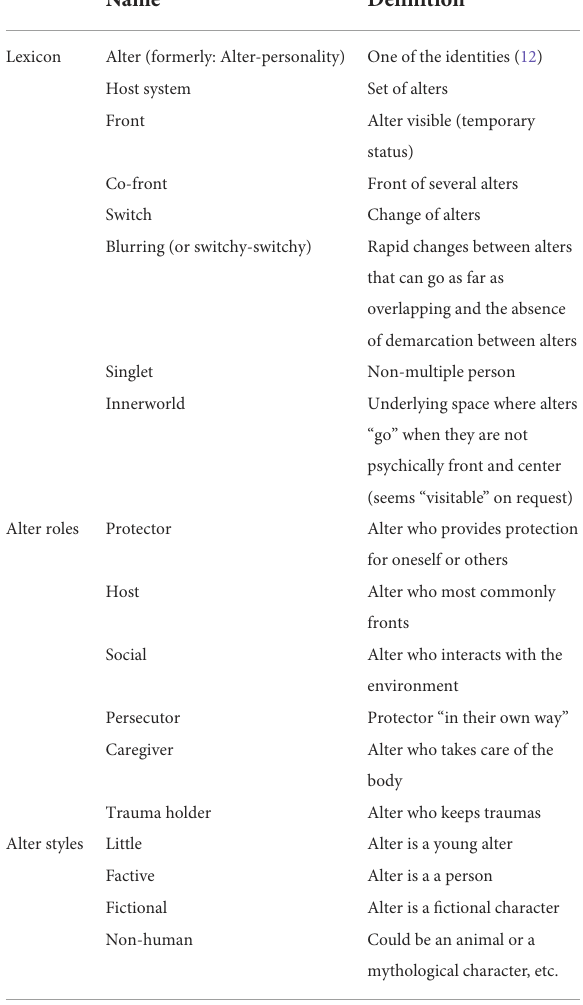
TABLE 2 Community